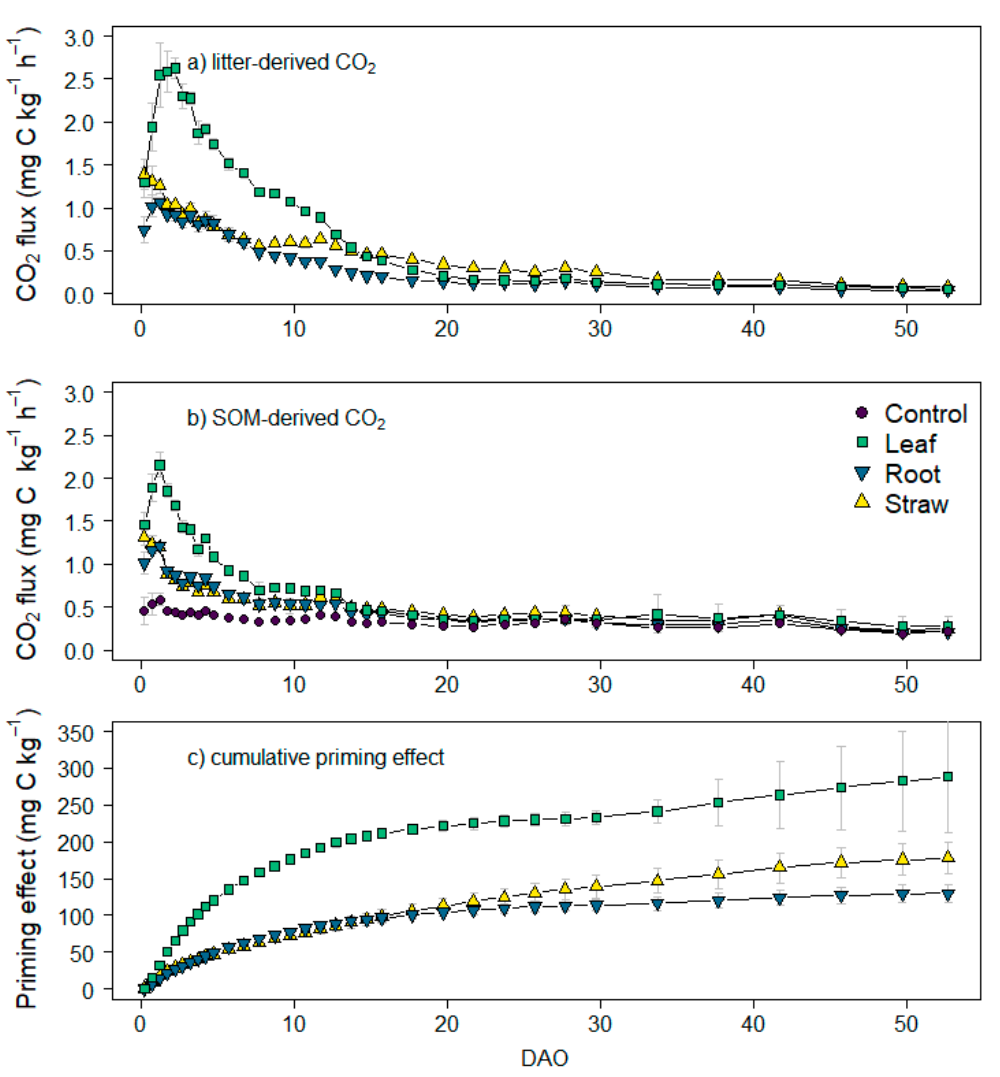
Figure 1. ( a ) Litter-derived CO 2 fluxes, ( b ) SOM-derived CO 2 fluxes, and ( c ) cumulative priming effect (means and standard deviation for n = 5, n = 4 for Control, when not visible, error bars are smaller than the symbols). Table 4. Cumulative SOM and litter-derived CO 2 emissions, and priming effect.